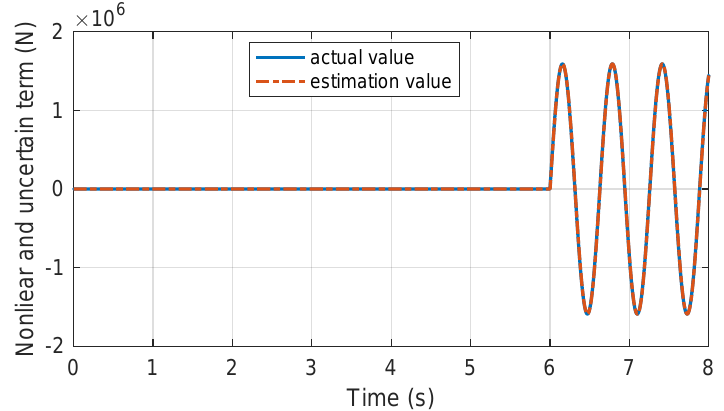
Figure 17. Estimation result for carriage 2 with the designed disturbance observer in case